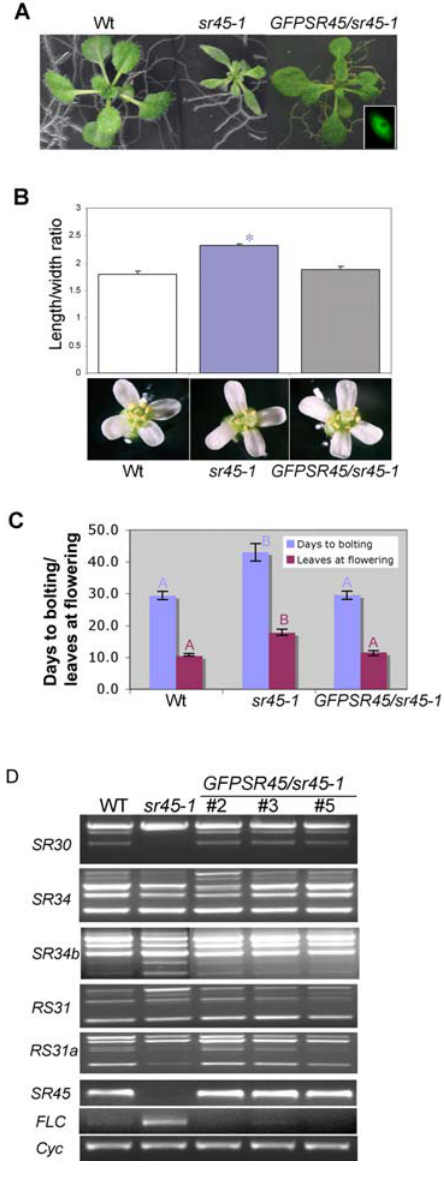
Figure 8. Full-length GFP-tagged SR45rescued the mutant pheno- types of sr45-1plants. (A) Growth of WT, sr45-1 and GFP-SR45 / sr45-1 plants. The narrow-leaf and stunted growth phenotype of sr45-1 was rescued by expression of GFP-SR45 in sr45-1 plants. Inset in the lower right corner shows a root epidermal nucleus of a GFP-SR45 / sr45-1 displaying the characteristic speckled distribution of GFP-SR45. (B) Petal shape phenotype of WT, sr45-1 and GFP-SR45 / sr45-1 . The p -values of t - test statistics are as follows: WT vs sr45-1 , p =0.000012 (significant); WT vs GFPSR45/sr45-1 , p =0.32 (non-significant). Significant difference is indicated by ‘*’. (C) Quantification of flowering time. Transition to reproductive stage was measured as days to bolting and number of rosette leaves at the appearance of 1 st flower. Each bar is the mean 6 SEM of 10 to 22 plants. Bars with same letter and the same color indicate non-significant difference ( p . 0.05). (D) Expression pattern of alternatively spliced transcripts of SR genes in WT, sr45-1 and GFP- SR45 / sr45-1 plants. Expression pattern of three independent GFP-SR45 / sr45-1 lines is shown. In all transgenic lines the splicing patterns of pre- mRNAs encoding SR proteins is restored to wild-type. Similar results were obtained in two independent RT-PCR analyses. For details on RT- PCR and primer sets used see Figure 3. Cyclophilin amplification was used to demonstrate equal amount of template in each PCR.